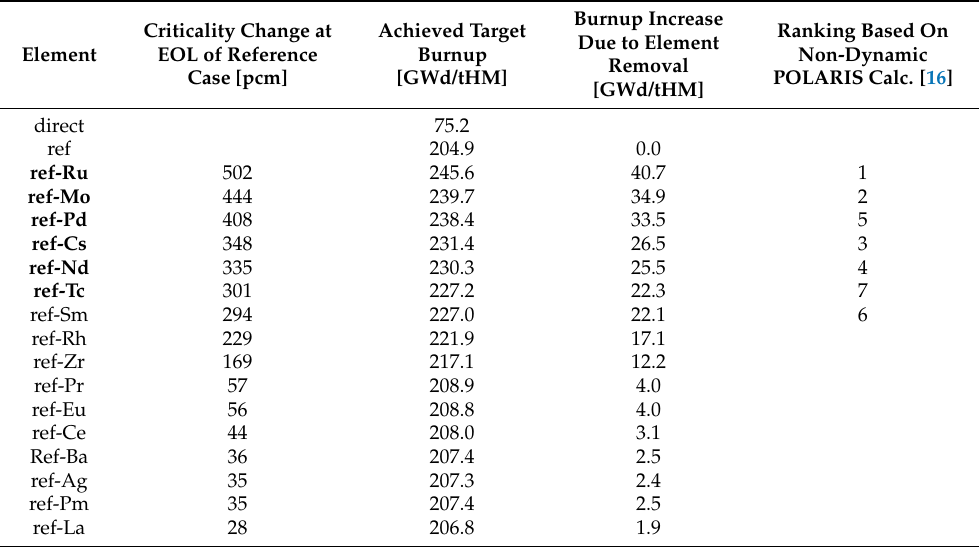
Table 2. Criticality gain, target burnup, and burnup gain achieved through removal of 5% of the specific fission product in after every 10 GWd/tHM burnup